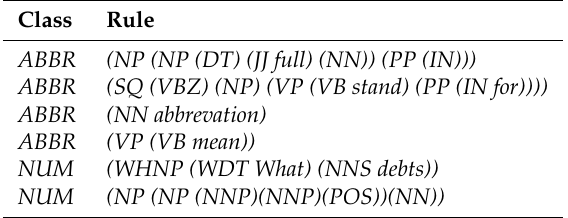
Table 4. Rules manually extracted for the question classification